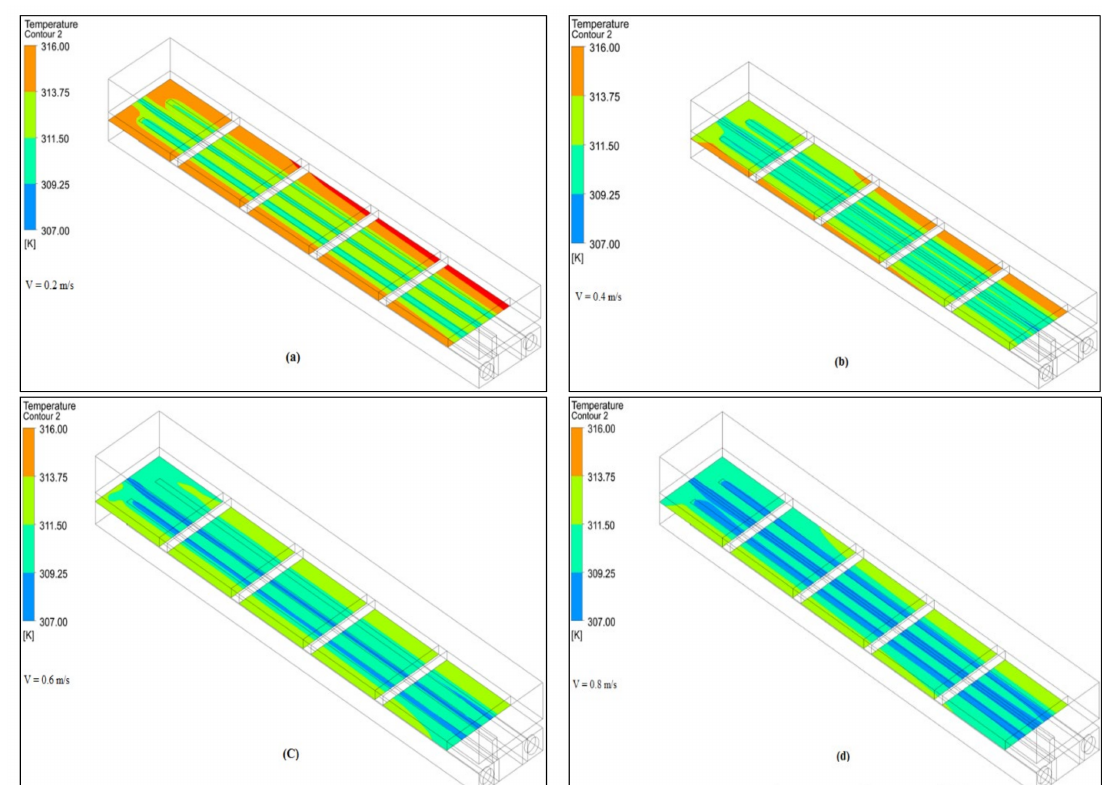
Figure 14. Temperature distribution contours at a plane just below the cold surface of the TEG for flow velocity: ( a ) 0.2 m/s, ( b ) 0.4 m/s, ( c ) 0.6 m/s, and ( d ) 0.8 m/s.